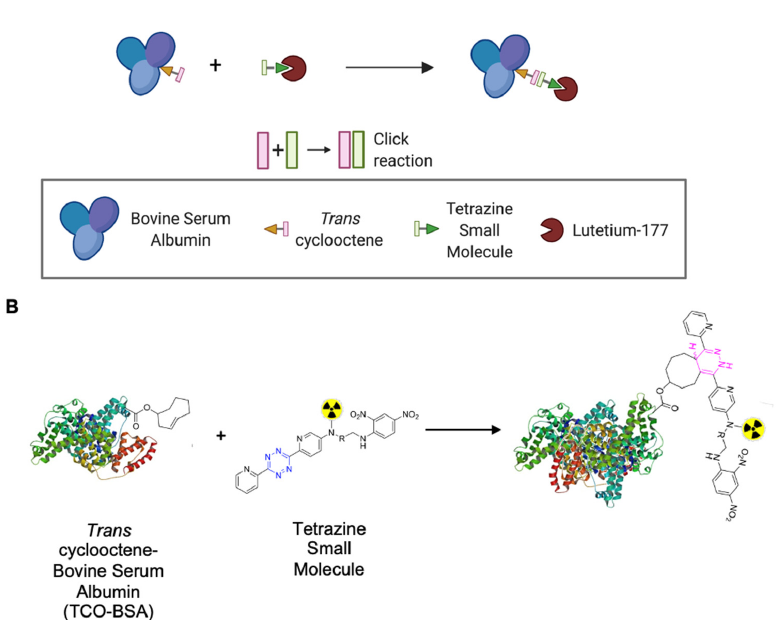
Figure 2. Schematic representation showing the inverse electron-demand Diels–Alder reaction between the trans-cyclooctene and tetrazine-based moieties. ( A ) Simplified schematic of the overall conjugation and labeling strategy. *Created using BioRender.com. ( B ) Schematic showing the key functional groups used to label albumin.